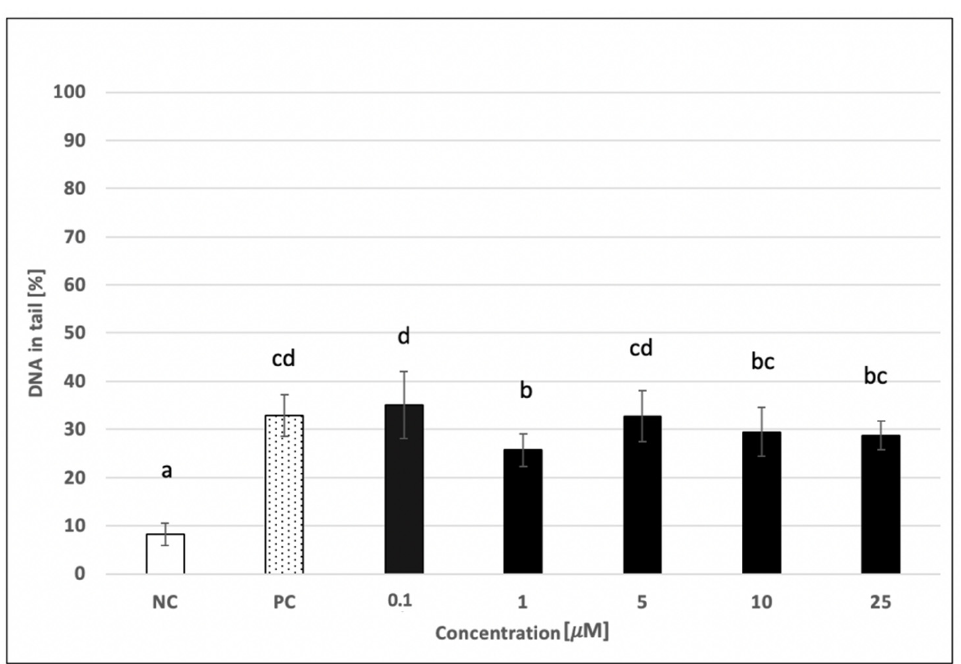
Figure 11. Evaluation of the potential DNA-protective effects of skyrin (SK) on the HepG2 cell line (24 h treatment) at different concentrations using the comet assay. Negative control (NC)—untreated cells; positive control for comet assay (PC)—cells treated with 1 mM hydrogen peroxide. Tested samples were treated with a different concentration of skyrin (24 h treatment), and hydrogen